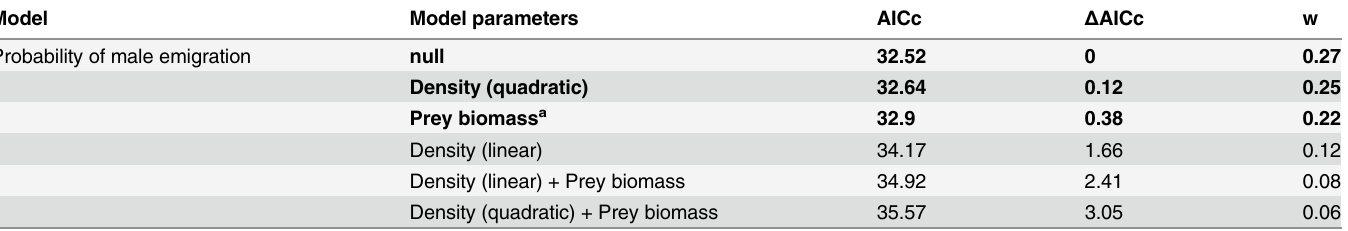
Table 4. A priori binomial regression models exploring the effect of time as a proxy for population density and prey biomass density on the proba- bility of dispersal in subadult male leopards in Phinda Private Game Reserve, South Africa, 2002 – 2012.